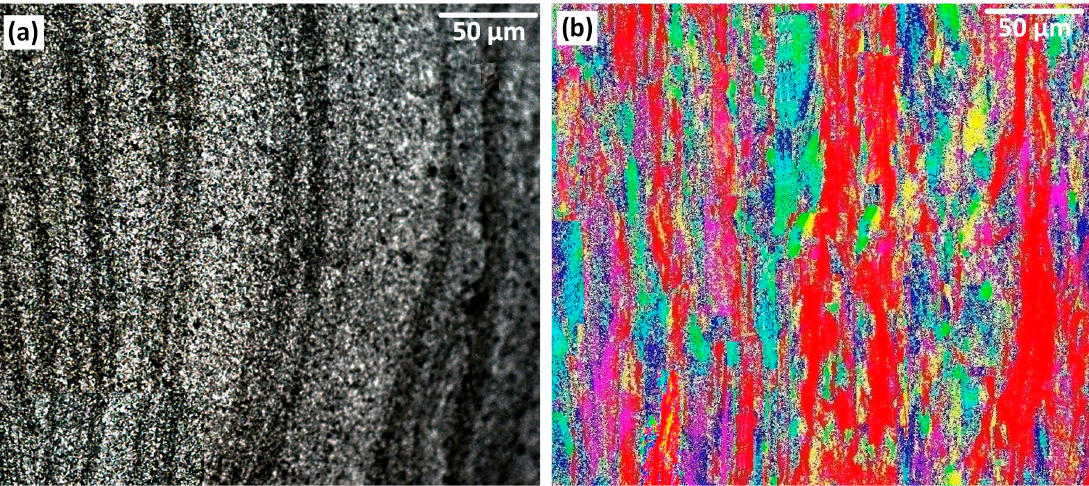
Figure 6. The microstructure of Flow layer patterns, ( a ) Optical microscopy and ( b ) EBSD colour map.